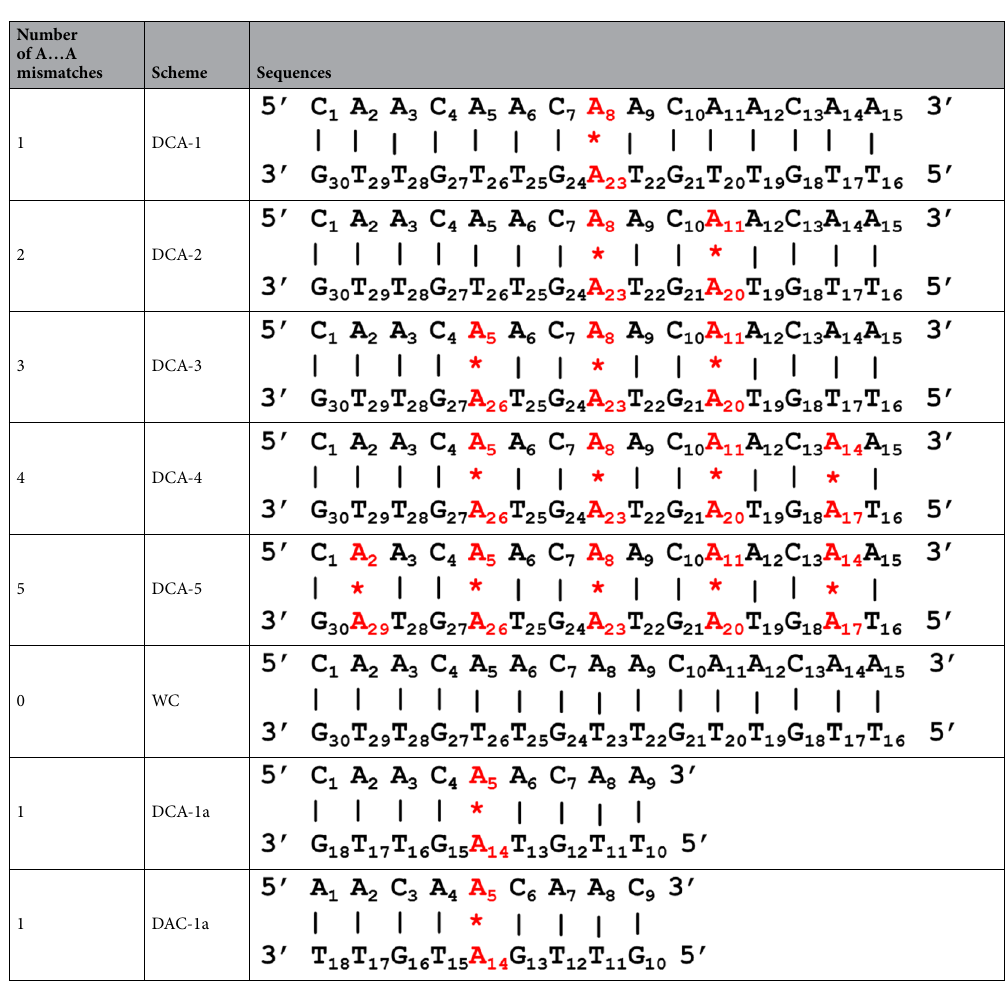
Table 1. DNA duplexes used in the current investigation. The canonical and the non-canonical base pairs are indicated by “|” and “*”